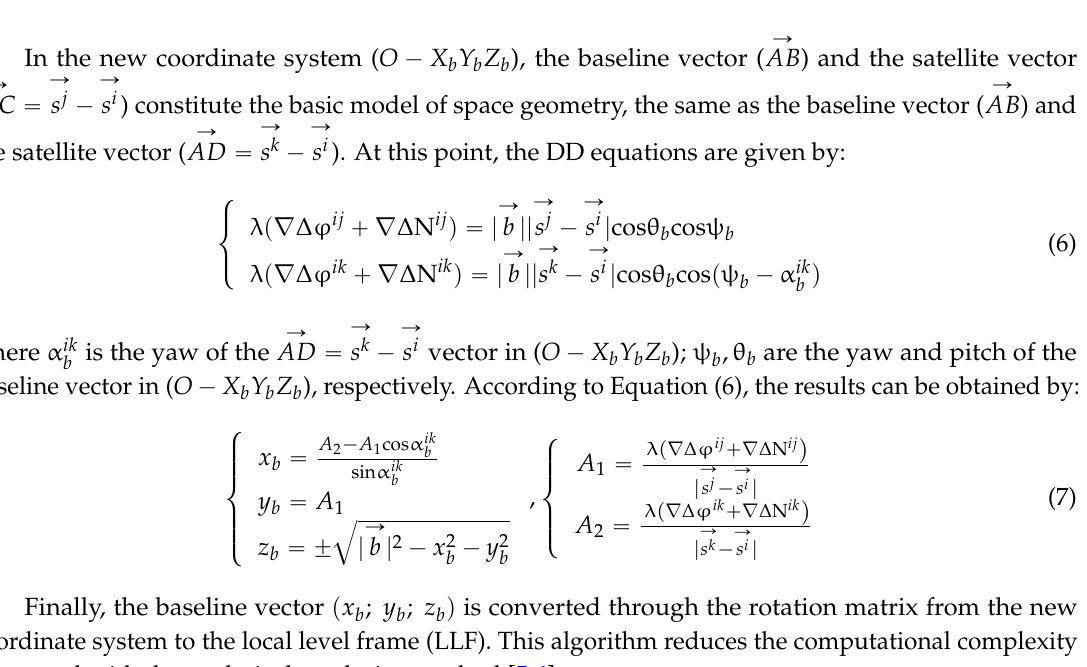
Figure 5. The spatial relation in the new coordinate system.